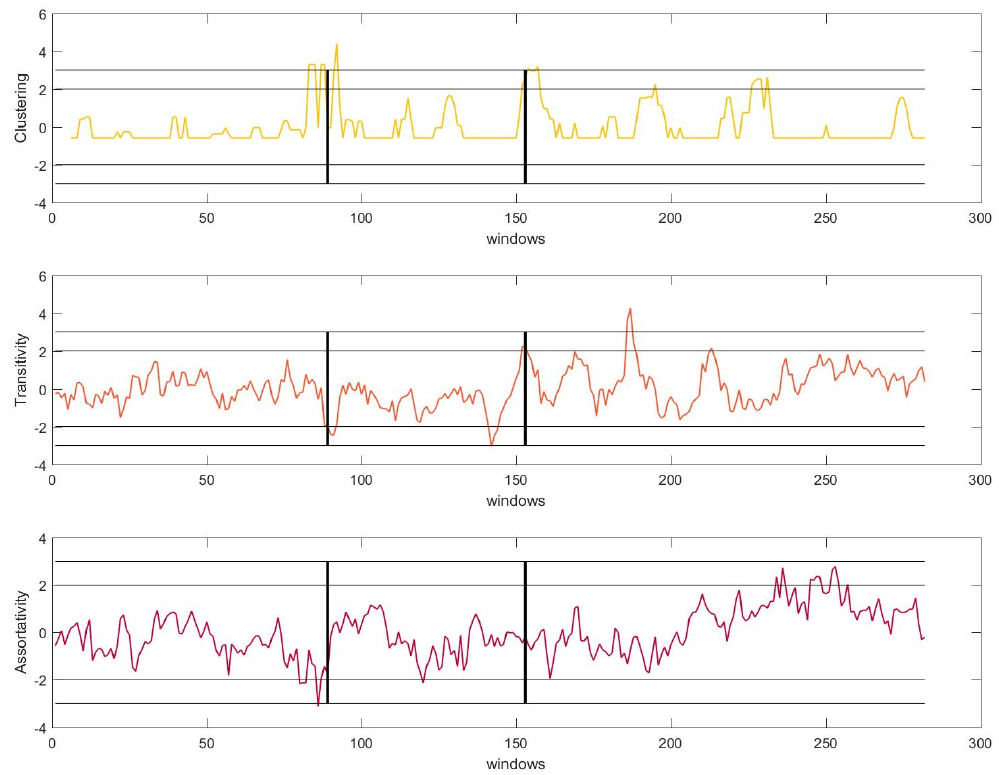
Figure 2. Moving window ε -recurrence network analysis showing the median moving average of clustering, transitivity and assortativity, before, during and after the start of the tremor, in that order. The left and right black vertical lines represent the transition from Non-Tremorous resting state ( NT ) to Tremor Onset ( TO ) and from TO to Tremor state ( T ), respectively. The horizontal lines represent the ± 2 and ± 3 standard deviation thresholds for statistical